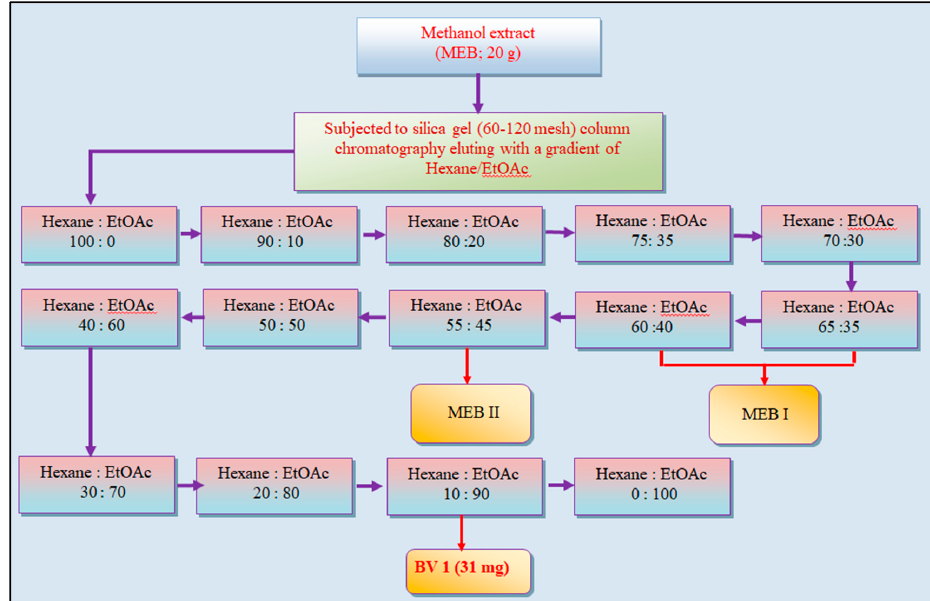
Figure 1. The schematic representation of column chromatography of methanol extract (MEB) of bark of Bauhinia variegata L. BV1 is the pure fraction obtained, subjected to further characterization. MEB I and MEB II are sub-fractions, subjected to further